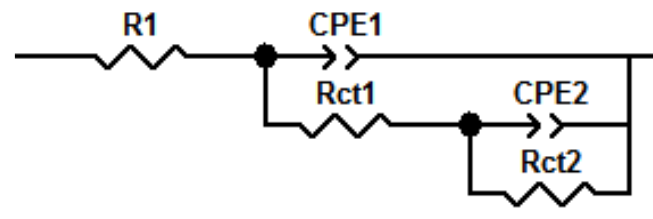
Figure 10. The equivalent circuit diagram of EIS. Table 6. Equivalent circuit fitting parameters of EIS for different